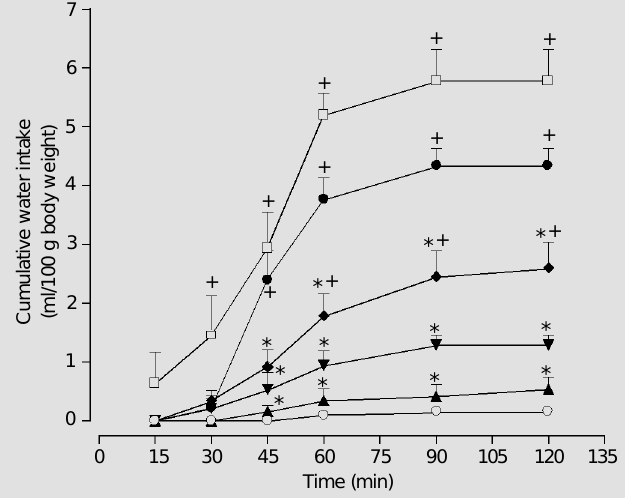
Figure 1 - Effect of zinc pretreatment on the dipsogenic effect of third ventricle isoproterenol (ISO) injection. Cumulative water intake (ml/100 g body weight) is reported as mean ± SEM in: (open circles) normohydrated control rats (NaAc + saline); (squares) animals treated with ISO (160 nmol/ rat) pretreated with saline (saline + ISO); animals pretreated with (closed circles) 0.3, (lozenges) 3.0, (inverted triangles) 30.0 and (triangles) 300.0 pmol/rat of Zn(Ac) 2 and treated with 160 nmol/rat of ISO. *P<0.05 compared to the saline + ISO group; + P<0.05 compared to the NaAc + saline group (ANOVA followed by the Student-Newman-Keuls test).